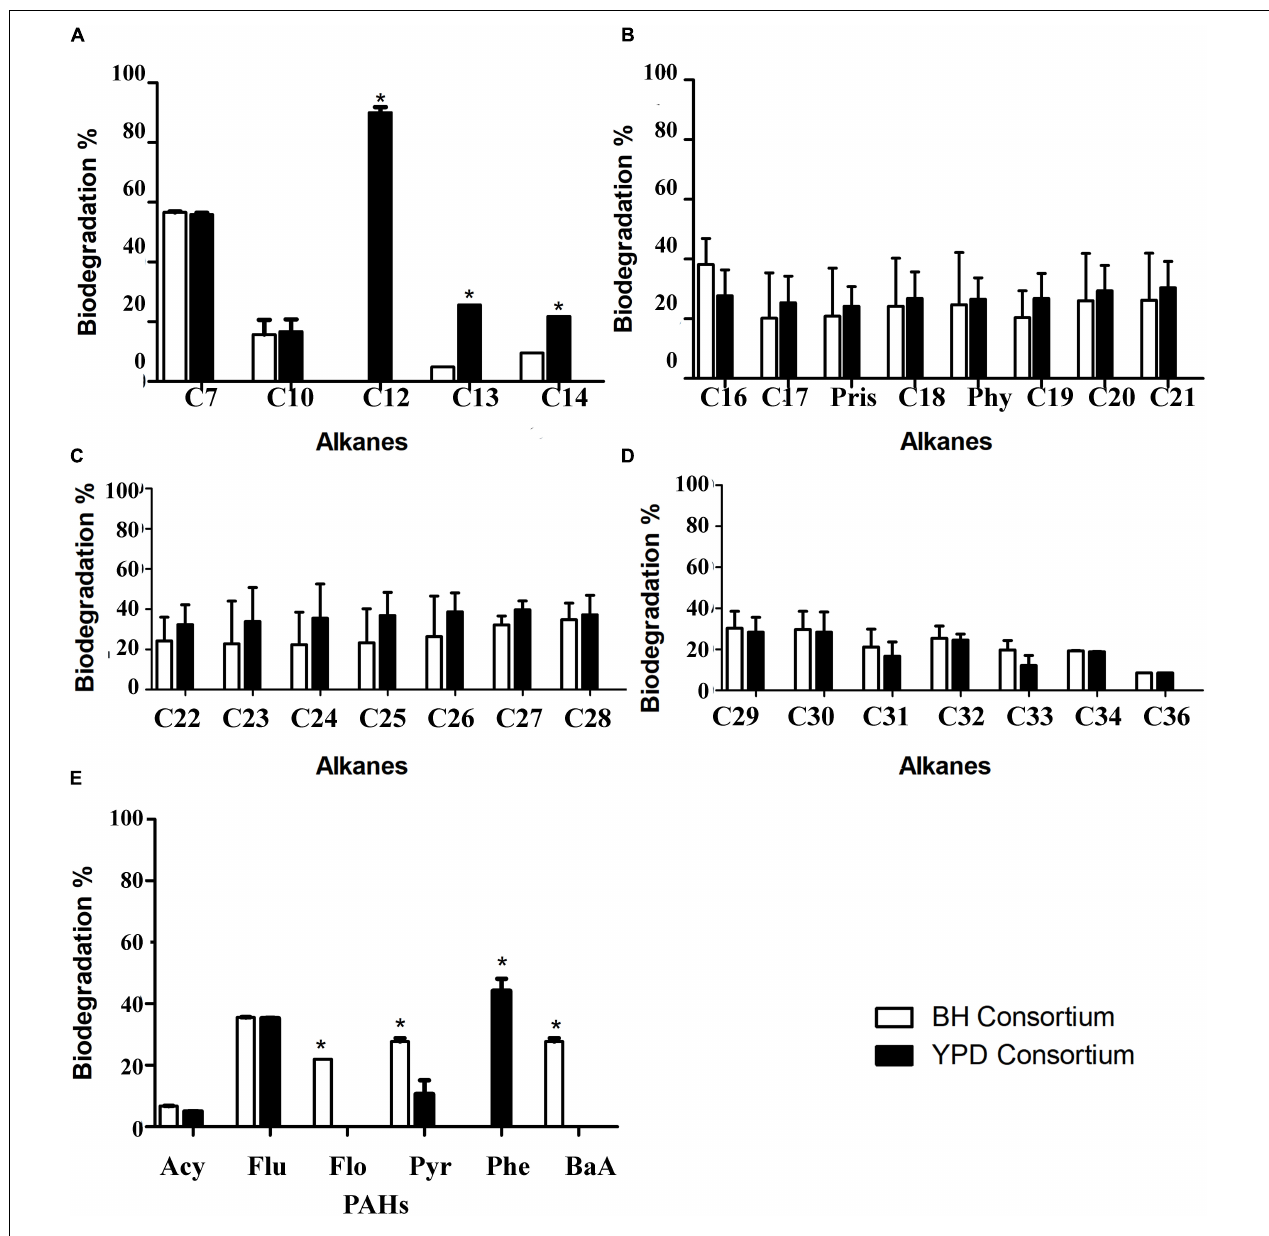
FIGURE 7 | Hydrocarbon biodegradation profiles of the BH and YPD consortia. (A) Comparison of biodegradation of short aliphatic hydrocarbons (from 7C to 14C) in percentages; (B) Biodegradation of aliphatic hydrocarbons (from 15C to 21C); (C) Biodegradation of long aliphatic hydrocarbons (from 22C to 28C); (D) Biodegradation of long aliphatic hydrocarbons (from 29C to 36C); and (E) Biodegradation of total polycyclic aromatic hydrocarbons (PAHs), in percentage, compared to the negative control only with mineral medium and petroleum analyzed by chromatography. All data were analyzed using two-way ANOVA (* p <